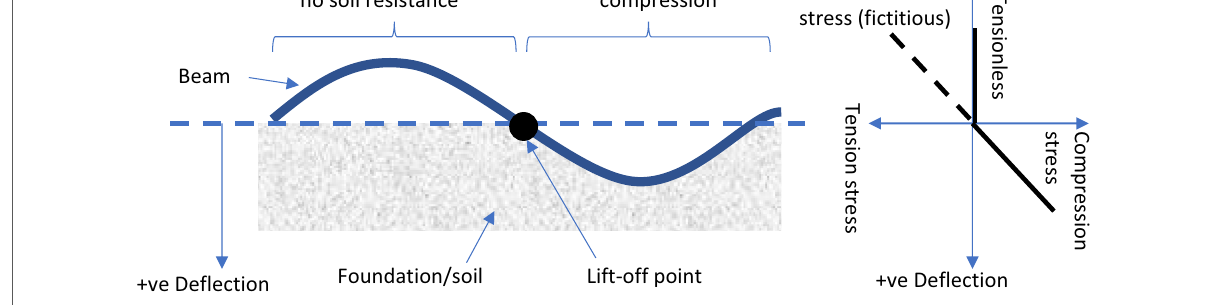
Fig. 1 Interaction of tensionless soil with a beam